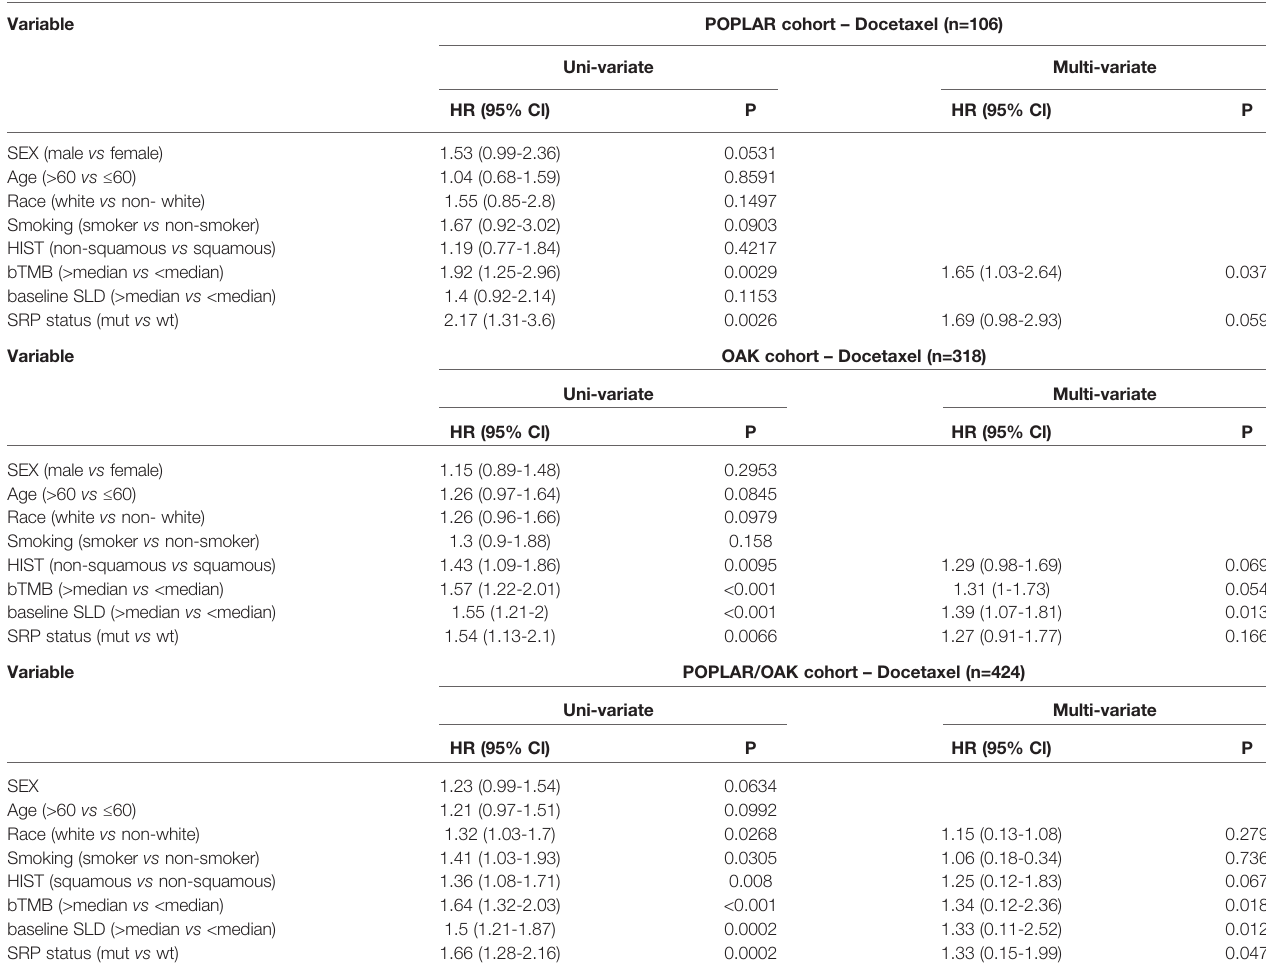
TABLE 3 | Hazard ratio (HR) of clinical and genomic variables on overall survival via univariate and multivariate analysis in patients treated with Docetaxel. Variable